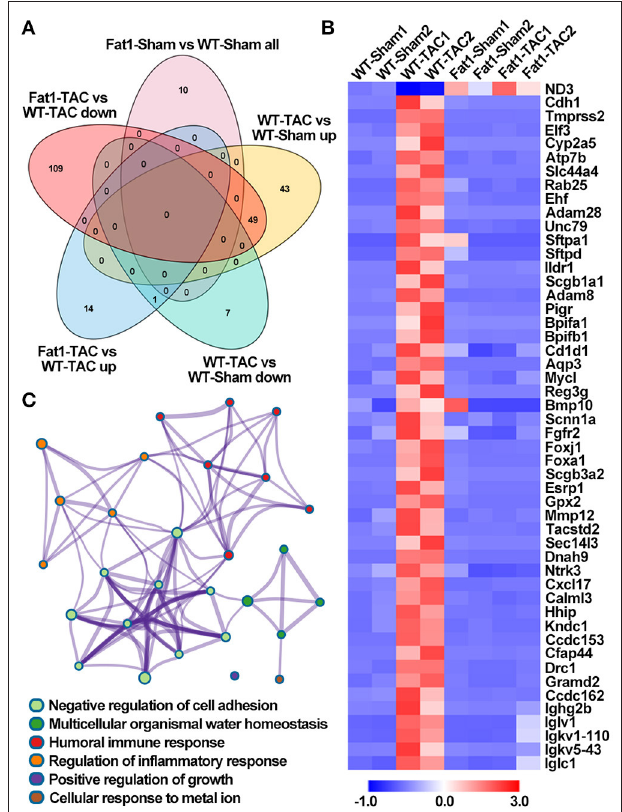
FIGURE 3 | Effects of endogenous N-3 PUFAs on the expression of genes under pressure overload. Gene set enrichment analysis revealed that pressure overload significantly up-/down regulated the biological processes enriched in DEGs, which can be suppressed/restored by fat-1 transgene (A,B) . Under pressure overload conditions, elevated endogenous PUFAs downregulated these 49 genes enriched in six biological processes (C) . Fat1-Sham vs. WT-Sham all, genes upregulated and downregulated by fat-1 transgene; WT-TAC vs. WT-Sham up, genes upregulated by TAC-induced pressure overload; WT-TAC vs. WT-Sham down, genes downregulated by TAC-induced pressure overload; Fat1-TAC vs. WT-TAC up, genes downregulated by fat-1 transgene under pressure overload conditions; Fat1-TAC vs. WT-TAC down, genes downregulated by fat-1 transgene under pressure overload conditions. N = 2 for